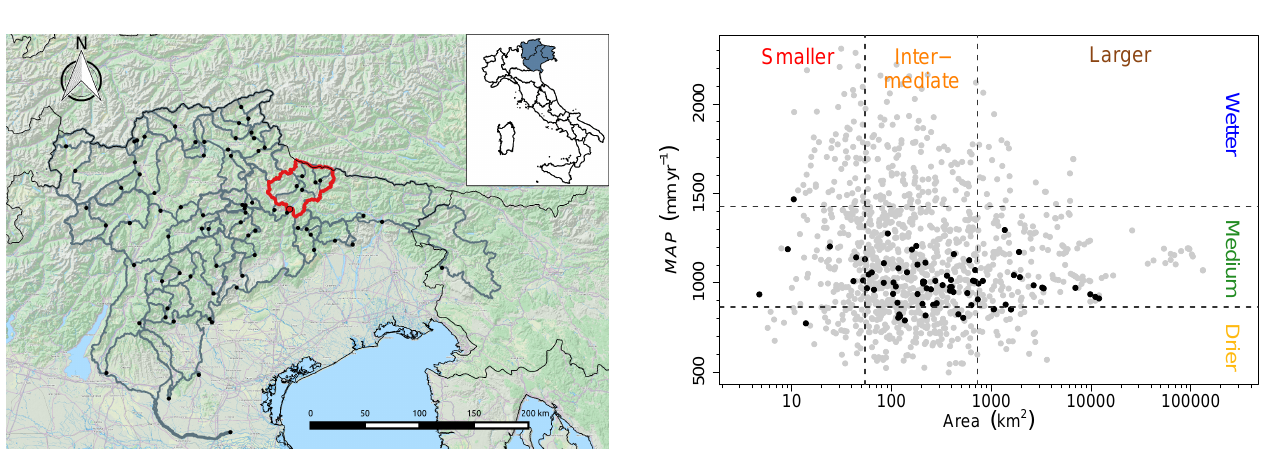
Figure 2. Catchment characteristics of the Triveneto data set (black points). Grey points represent the Austrian, Slovakian and Italian data sets considered in Salinas et al. (2014). Black-dashed lines identify the subdivision into the six subsets based on the 20 and 80% quantiles of the catchments descriptor values for the European data